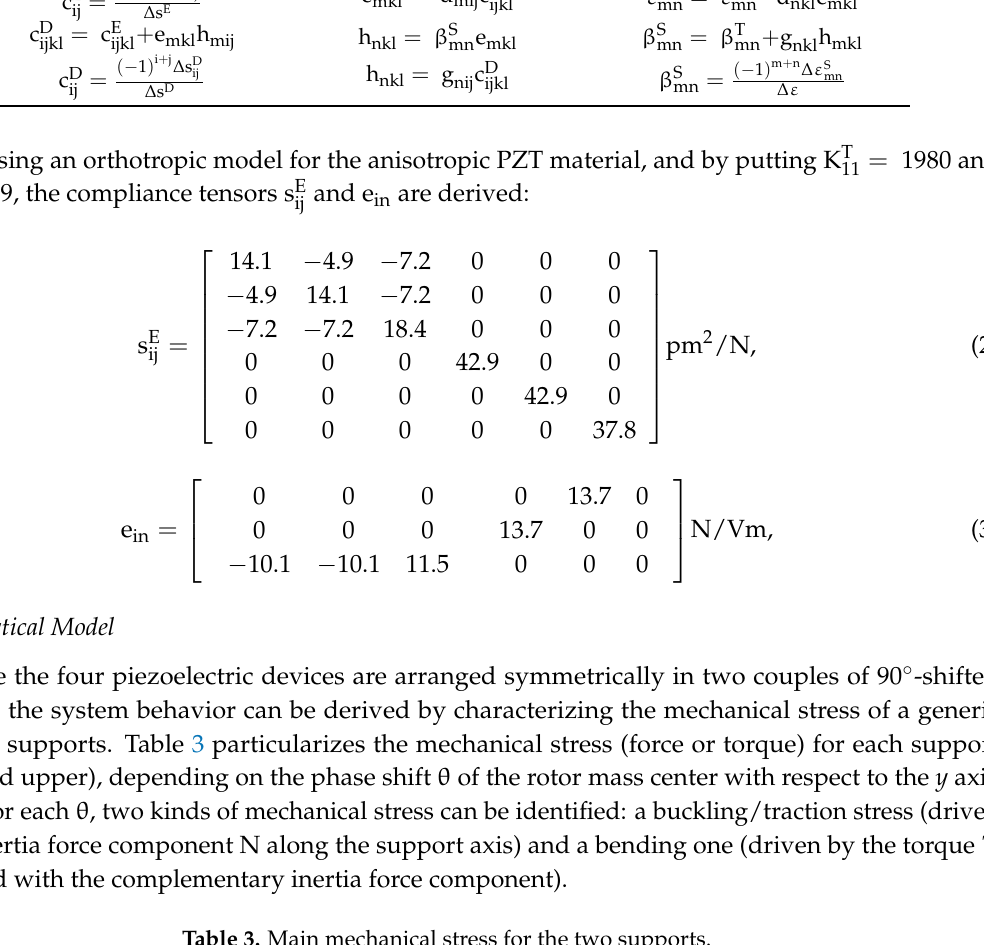
Table 3. Main mechanical stress for the two